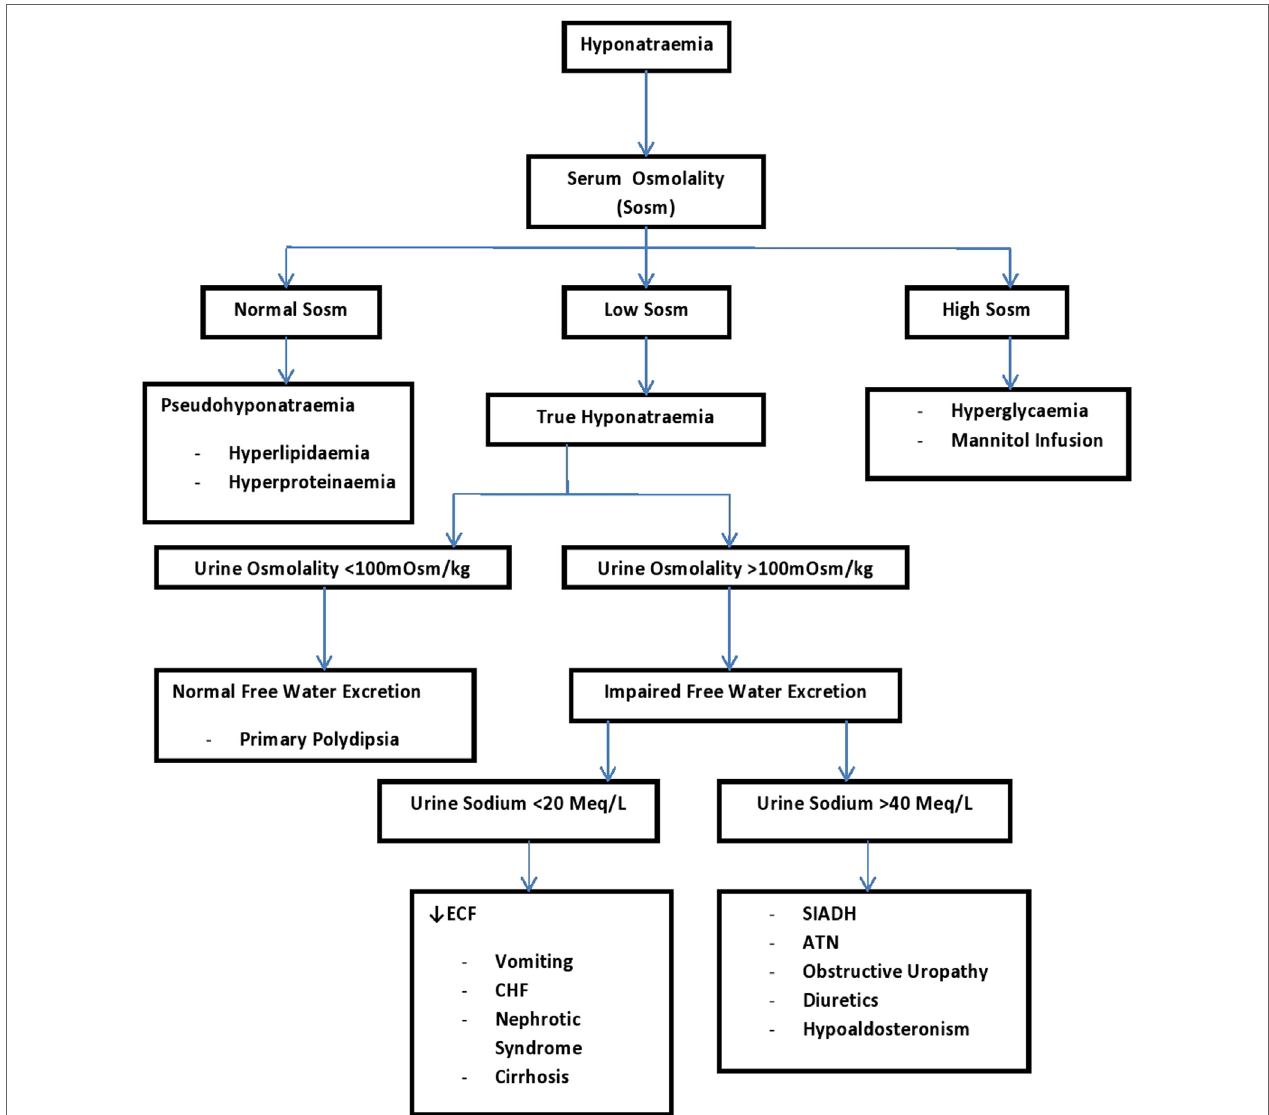
FiGURe 3 | A systematic approach to a patient with hyponatremia using urine sodium and urine osmolality (34). ATN, acute tubular necrosis; CHF, congestive heart failure; ECF, extracellular fluid; SIADH, syndrome of inappropriate antidiuretic